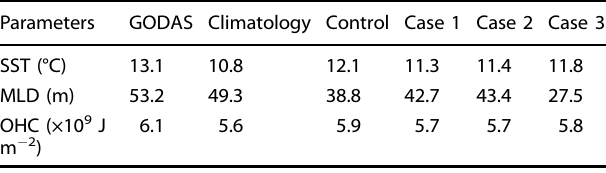
Table 1. Winter values of the SST, MLD, and OHC for the four model runs (Control, Case 1, Case 2, and Case 3) and the climatology in the NE Paci fi c.